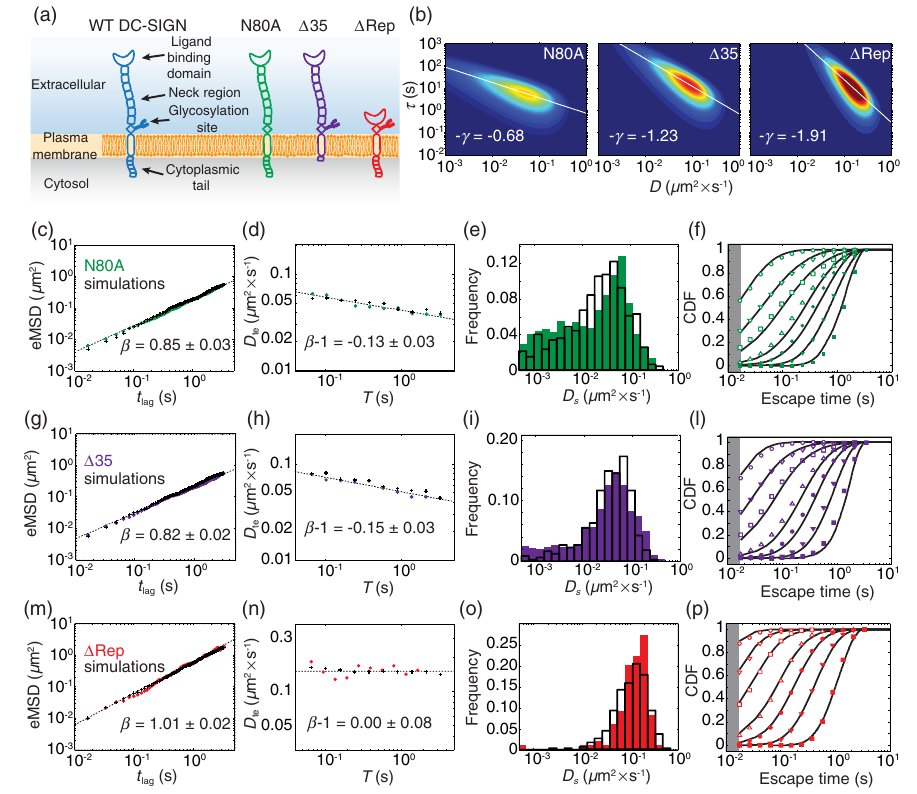
FIG. 5. Effect of mutations on the dynamics of DC-SIGN. (a) Schematic representation of WT DC-SIGN and its mutated forms. (b) Contour plot of the probability distribution of the simulated diffusion coefficient ( D ) and transit time ( τ ) for the parameters reproducing the dynamics of N80A ( σ ¼ 0 . 58 , γ ¼ 0 . 68 , b ¼ 0 . 09 μ m 2 = s, k ¼ 0 . 74 μ m 2 γ s γ þ 1 ), Δ 35 ( σ ¼ 1 . 04 , γ ¼ 1 . 23 , b ¼ 0 . 08 μ m 2 = s, k ¼ 0 . 07 μ m 2 γ s γ þ 1 ), and Δ Rep ( σ ¼ 2 . 11 , γ ¼ 1 . 91 , b ¼ 0 . 07 μ m 2 = s, k ¼ 0 . 07 μ m 2 γ s γ þ 1 ). The white line represents the power-law dependence between diffusivity and average transit time with exponent − γ . (c) Log-log plot of the ensemble-averaged MSD for N80A trajectories (filled circle) and simulated data ( þ ). (d) Log-log plot of the time-ensemble-averaged diffusion coefficient for N80 A trajectories (filled circle) and simulated data ( þ ) as a function of the observation time T . (e) Distribution of short-time diffusion coefficients as obtained from linear fitting of the time-averaged MSD for the N80A (filled bars) and the simulated trajectories (empty bars). (f) CDF of the escape time for N80A (symbols) and simulated trajectories (lines) for different radii. The meaning of the symbols is the same as in Fig. 2(f). (g) – (l) Dynamical behavior of the Δ 35 mutant. (m) – (p) Dynamical behavior of the Δ Rep